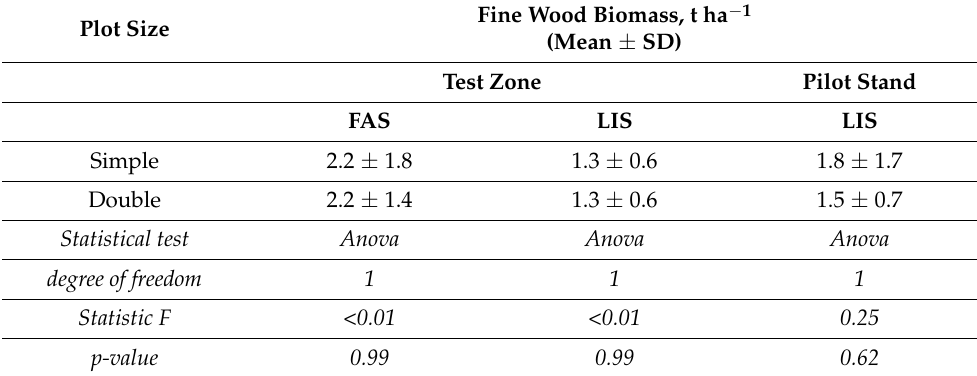
Table 3. Fine woody biomass estimated according to plot size and method: the fixed-area sampling